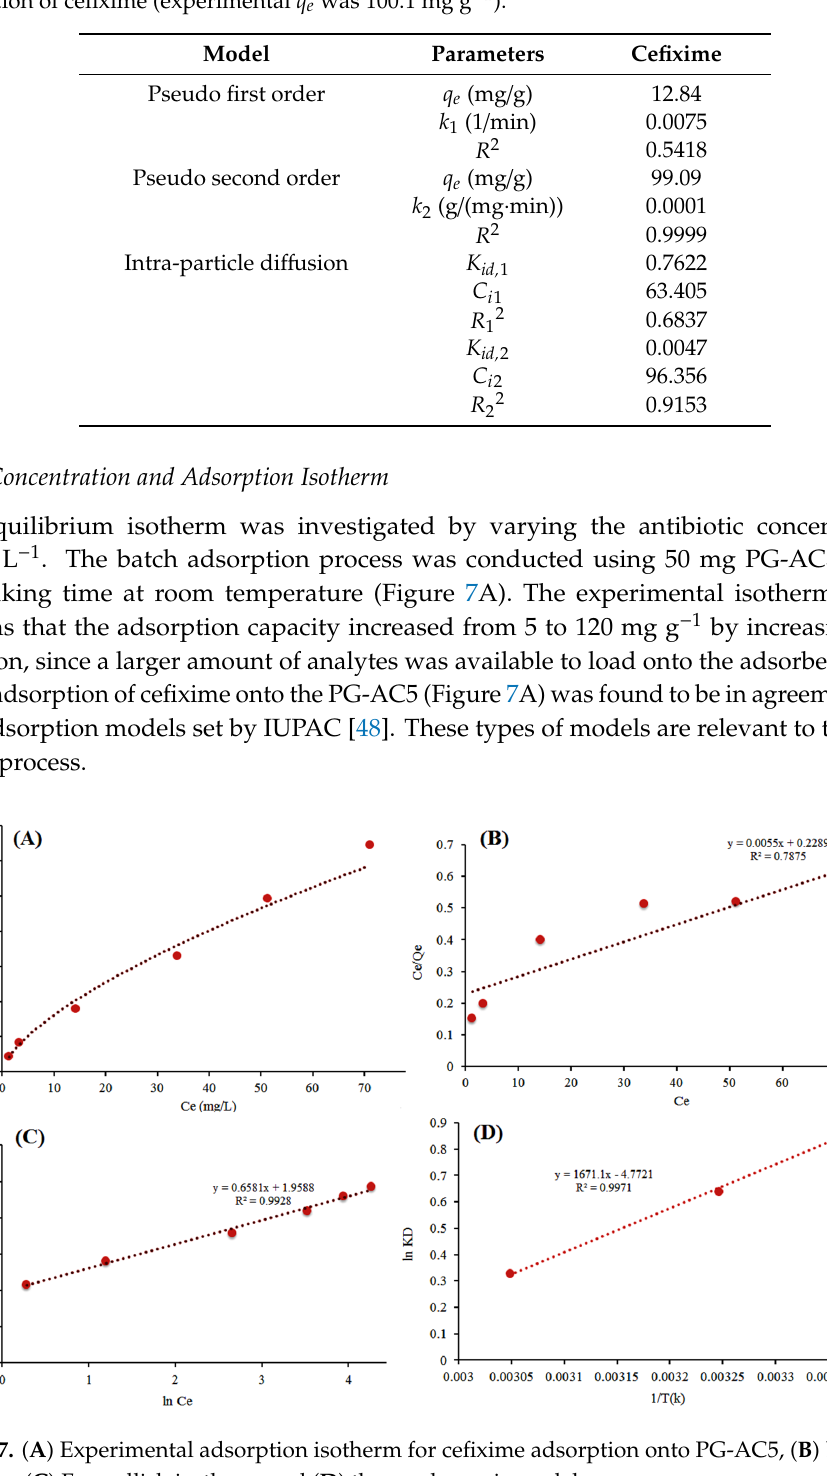
Table 1. The pseudo-first-order, pseudo-second-order and intra-particle di ff usion parameters for the adsorption of cefixime (experimental q e was 100.1 mg g − 1 ).